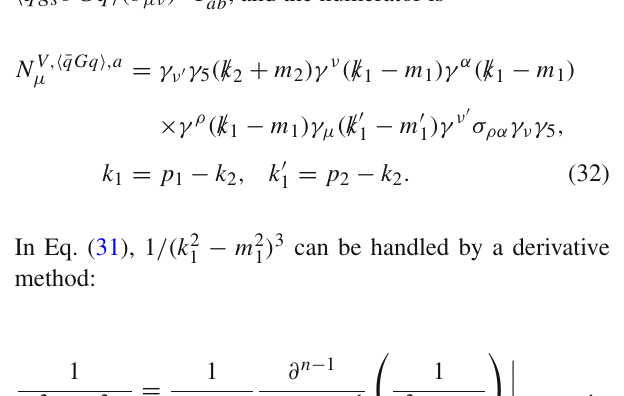
(cid:6) = − ( 1 / 192 ) g s G c μν ¯ q j a b